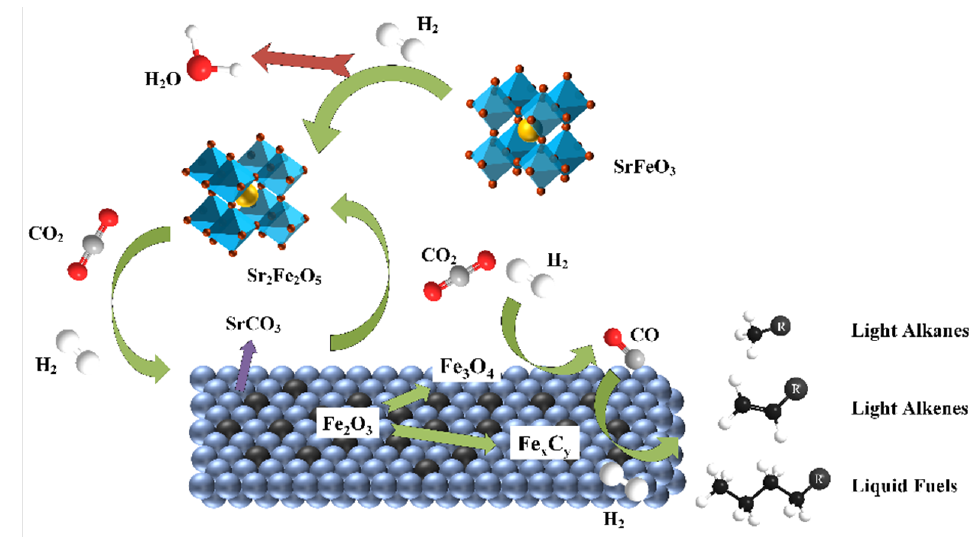
Figure 13. Mechanism of CO 2 hydrogenation on SKFx perovskite to generate products.